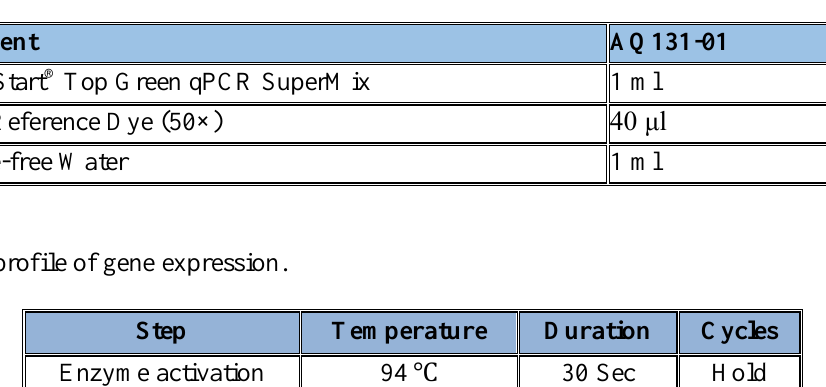
Table 4: Components of quantitative real-time PCR used in gene expression experiment.